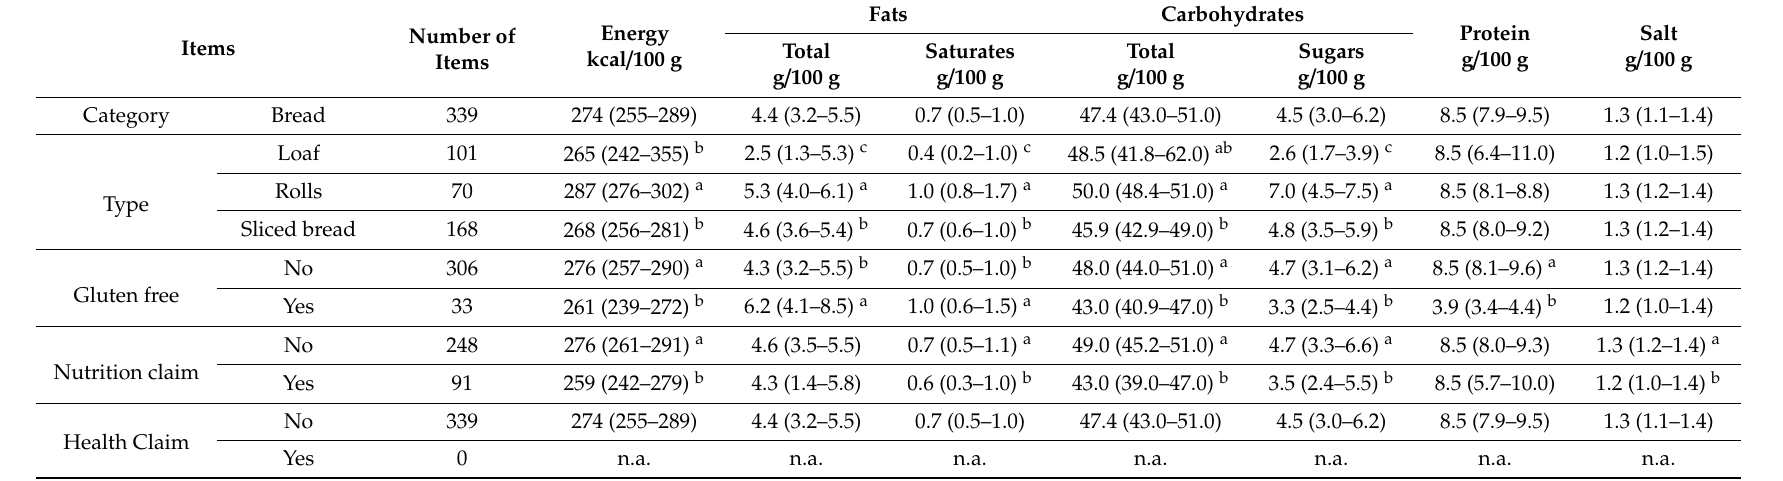
Table 1. Energy, macronutrients and salt across bread